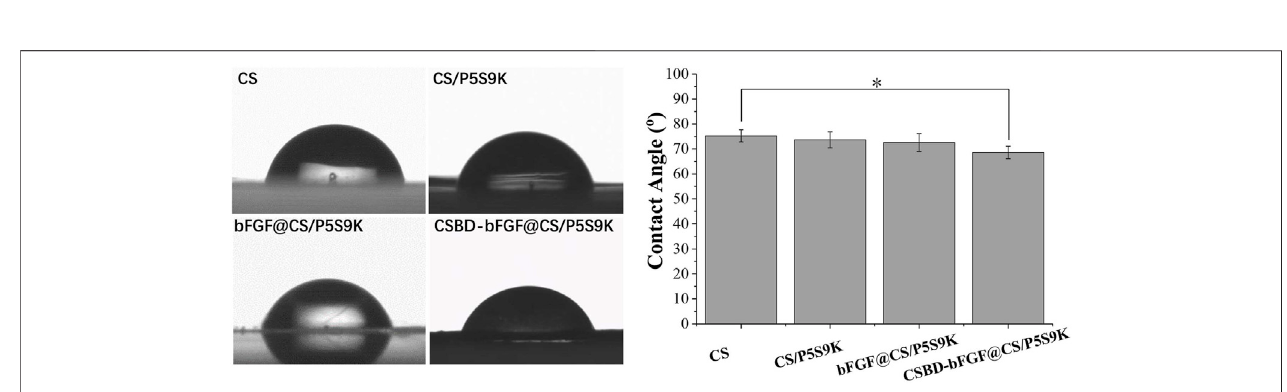
FIGURE 5 | The water contact angles of the CS, CS/P5S9K, bFGF@CS/P5S9K and CSBD-bFGF@CS/P5S9K membranes, n = 5, p < 0.05.